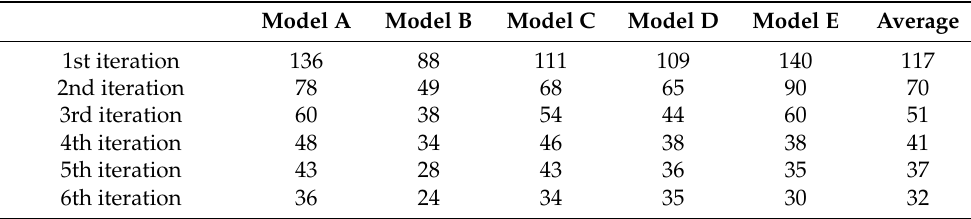
Figure 6. The results of the prediction model. The Moscow cohort ( A – C ) alone had a poor average result of AUROC = 0.81 and accuracy = 0.67, with a total of four rounds of 100 runs, and the optimal average feature set was 41 species. The Shenzhen cohort alone achieved a high value of AUROC = 0.984 and accuracy = 0.968 with just one round of 100 runs, and the optimal model used an average of 39 species of the full set of 285 species as features. For the combination of two cohorts ( D – F ), the optimal model was achieved in the third round, showing the average prediction result of AUROC = 0.86, accuracy = 0.80, and an average feature set of 67 species. Table 3. The number of species as important features in the five optimal prediction models selected in each iteration of the Moscow cohort. The iterations became stabilized in the fourth round.